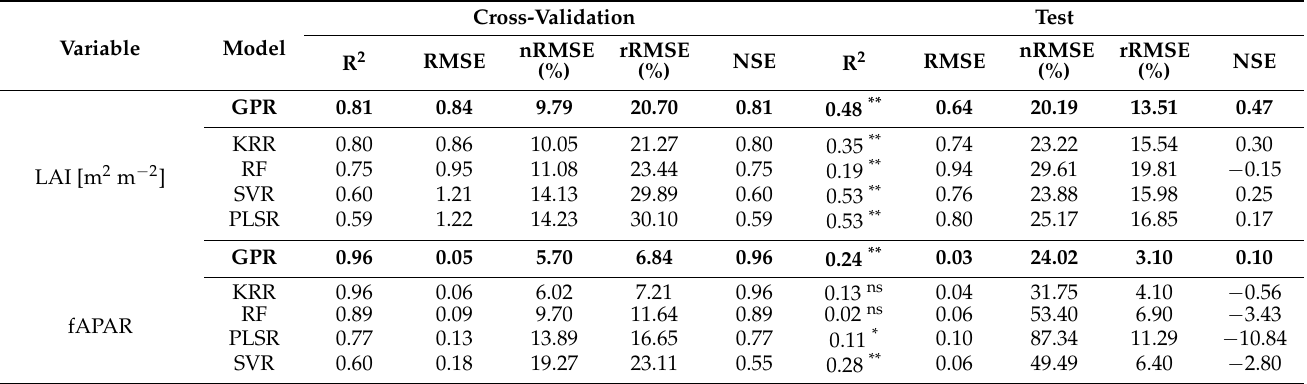
Table 8. Results of biophysical variables retrieval with a nonparametric model, n_training =